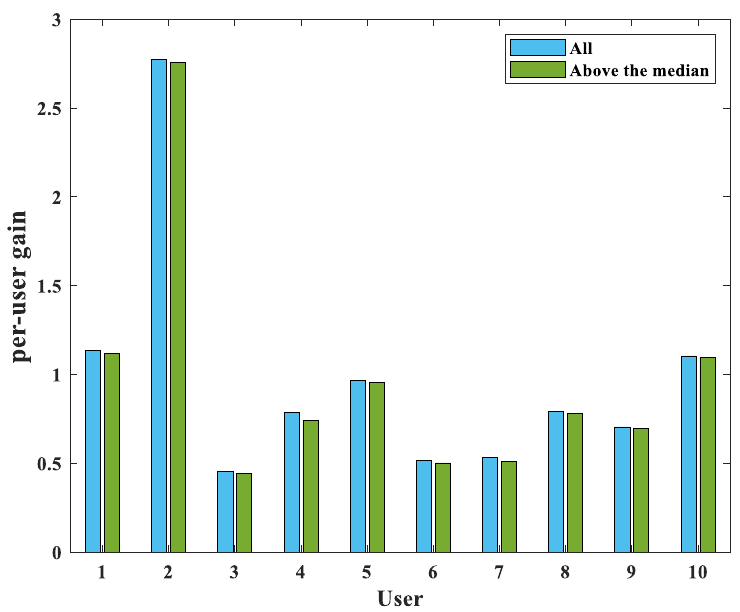
Figure 3. Bar graph of the total sum rate for 20 users and the sum of above the